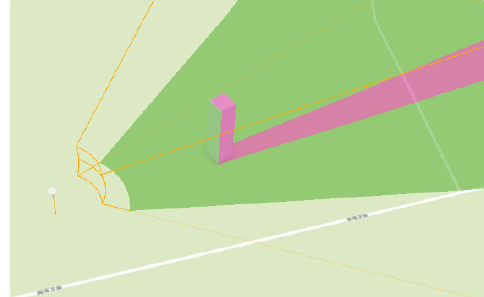
Figure 5. Scenario of 3D FOV and terrain.